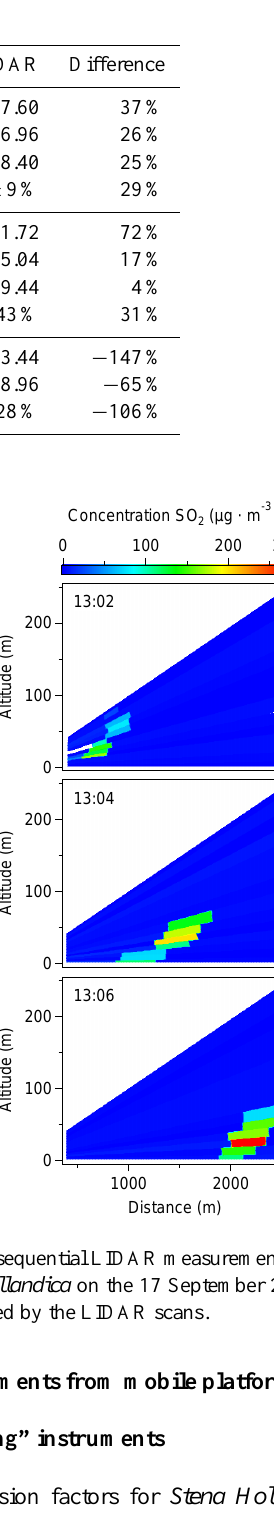
Table 3. Comparison of SO 2 emission rates in kgh − 1 given by DOAS and LIDAR techniques. In the last column, relative differences are presented (DOAS-LIDAR).